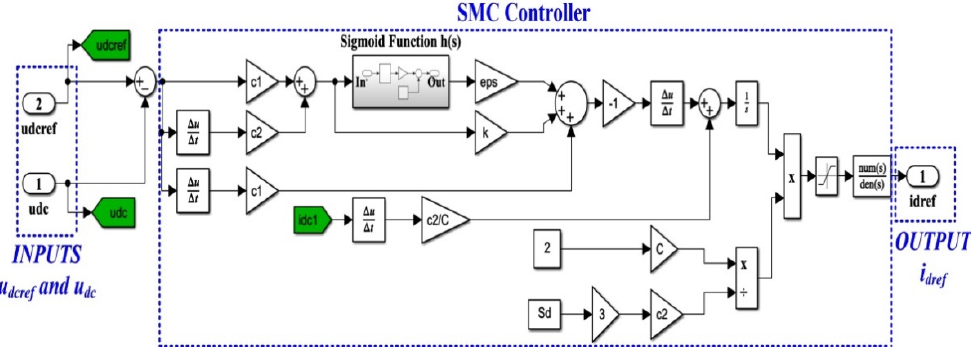
Figure 18. The MATLAB Simulink subsystem implementation of the SMC controller.